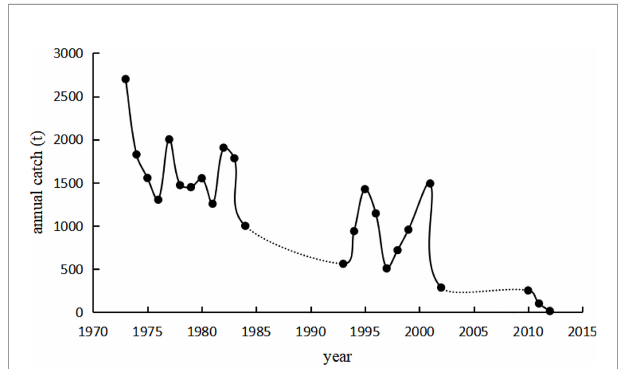
FIGURE 1 | Annual catch of Coilia nasus in the lower reaches of the Yangtze River. The data for 1973 – 1984, 1993 – 2002, and 2010 – 2012 are from Yuan (1988); Zhang et al. (2005), and Liu et al. (2012), respectively. The dashed lines indicate where data was not available.